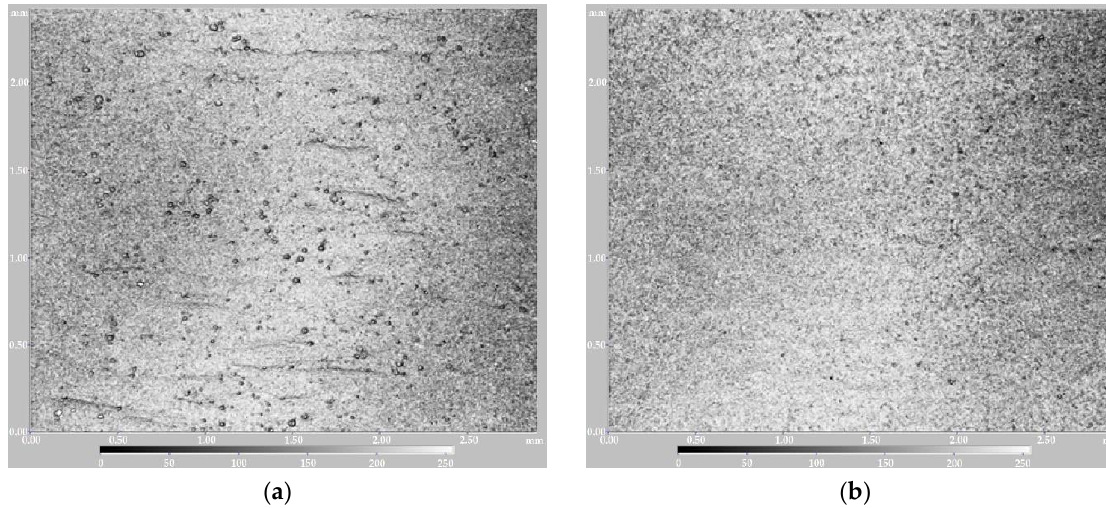
Figure 5. Three-dimensional (3D) presentation of the laser additively produced part surface made of 12Cr18Ni9Ti austenite chrome–nickel stainless steel (analog of AISI 321) powder with granules of ≈ 20 µ m (by a MikroCAD-lite 3D measuring system, GFMesstechnik, Notzingen, Germany): ( a ) after production; ( b ) after vibratory